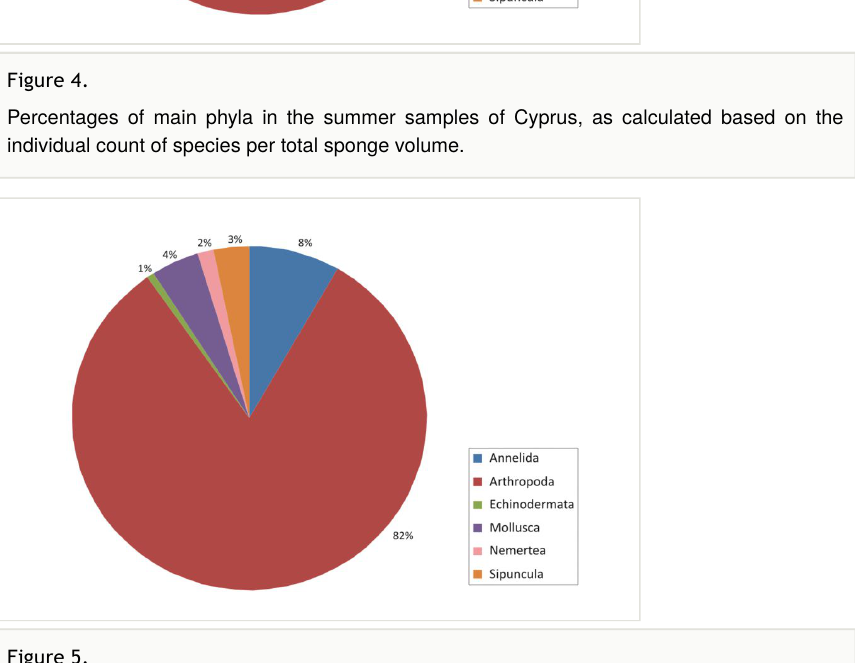
Figure 5. Percentages of main phyla in the winter samples of Cyprus, as calculated based on the individual count of species per total sponge